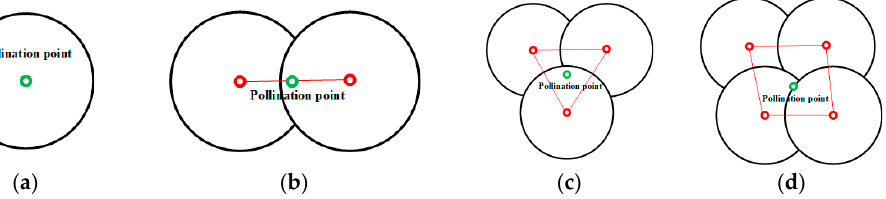
Figure 6. Schematic of pollination points under overlapping conditions: ( a ) single flower; ( b ) overlap of two; ( c ) overlap of three; ( d ) four or more overlapping.